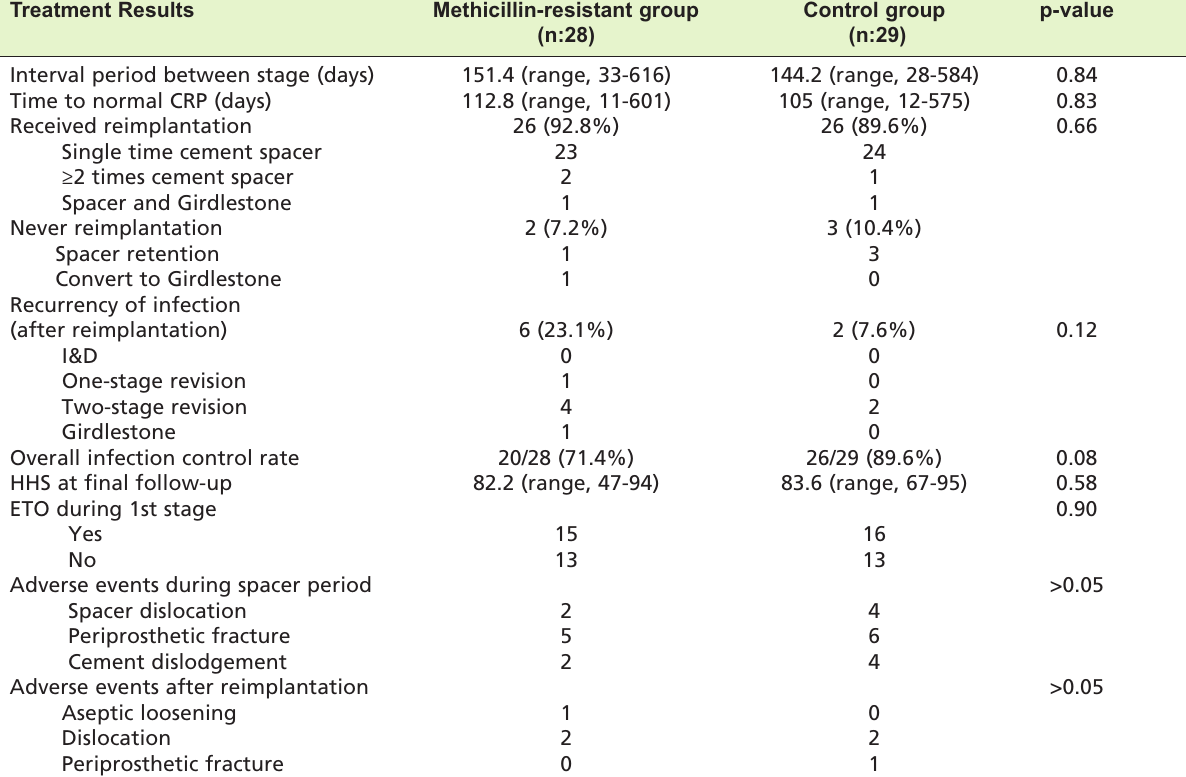
Treatment results of two-stage revision of Methicillin-resistant group versus control group Table II: Treatment